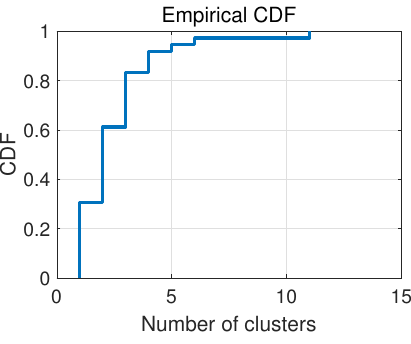
Figure 11. Clustering results at 36 different